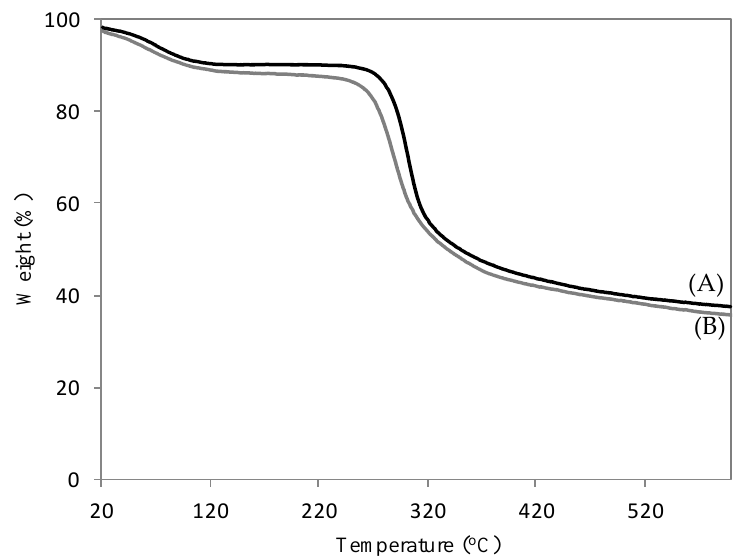
Figure 4. TG curves of the chitosan ( A ) and the 4–CH–SO 3 H catalyst ( B ).